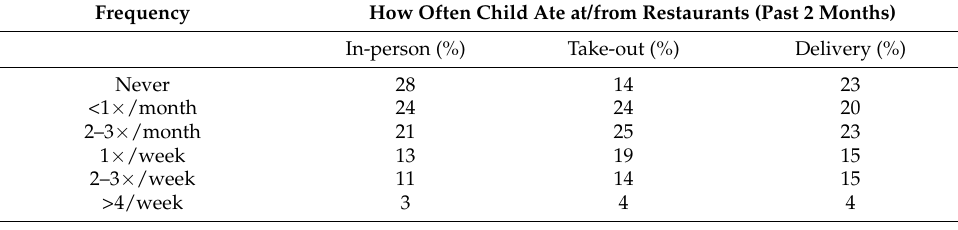
Table 5. Parent-reported restaurant use and ordering for their 4- to 8-year-old-child and perceived restaurant safety ( n = 1000